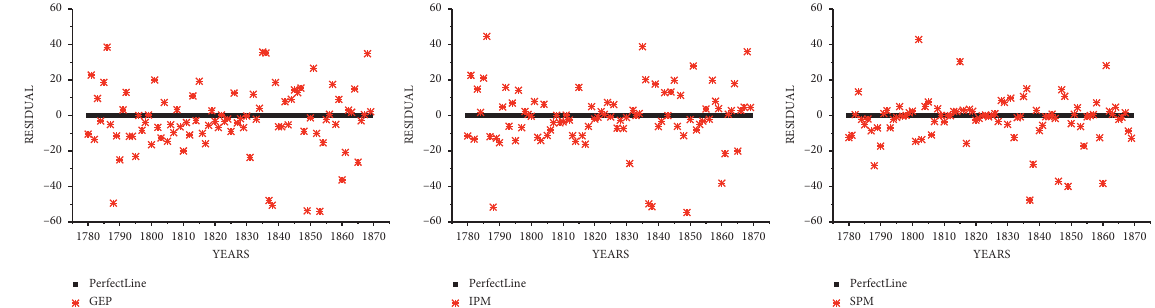
Figure 8: GEP-IPM-SPM regression prediction